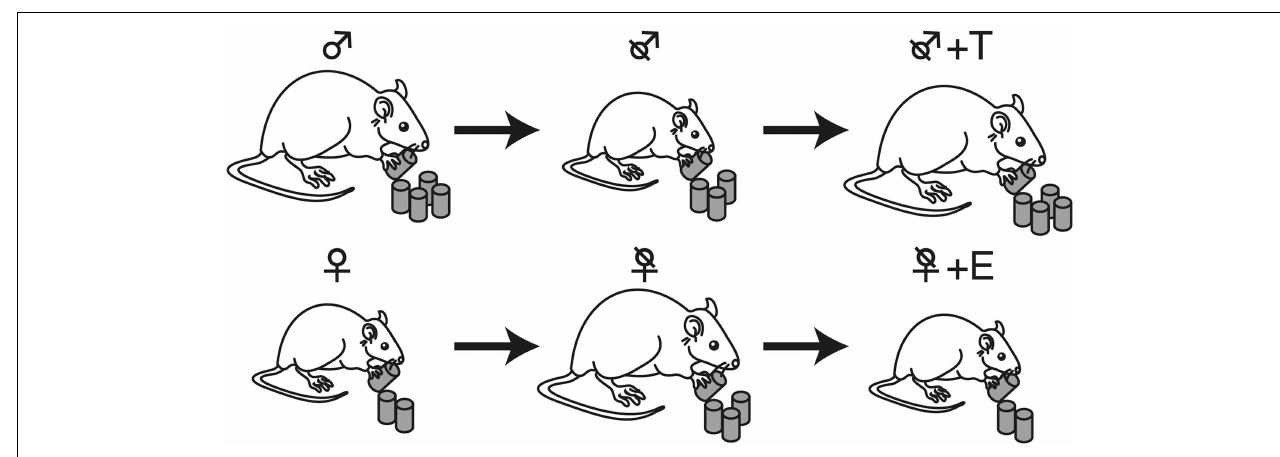
FIGURE 3 | Effects of gonadectomy and gonadal steroid hormones on feeding. Males ( ♂ ) eat more than females ( ♀ ), but gonadectomy ( \ ) had the opposite effect: castration of males resulted in weight loss because of